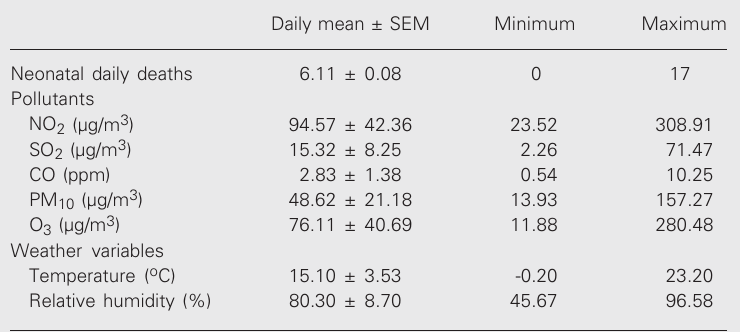
Table 1. Descriptive data for the main variables used in the analysis.